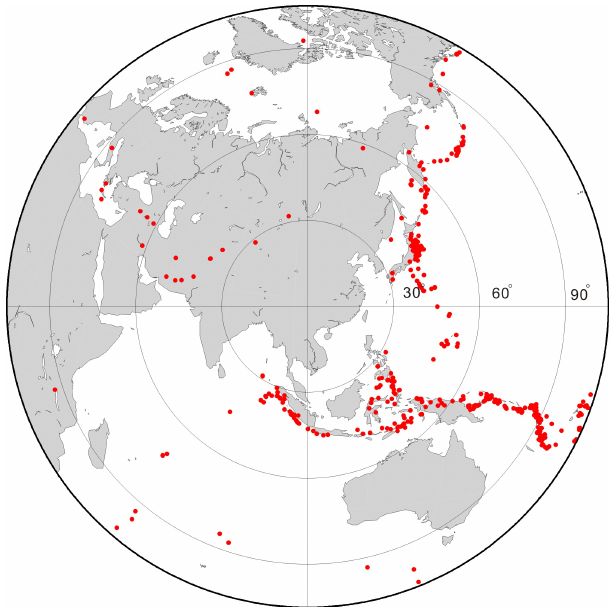
Figure 2. Seismic events used in this tomographic study. The 371 events with epicentre distance range from 30 to 85 ◦ for each station–event pair.